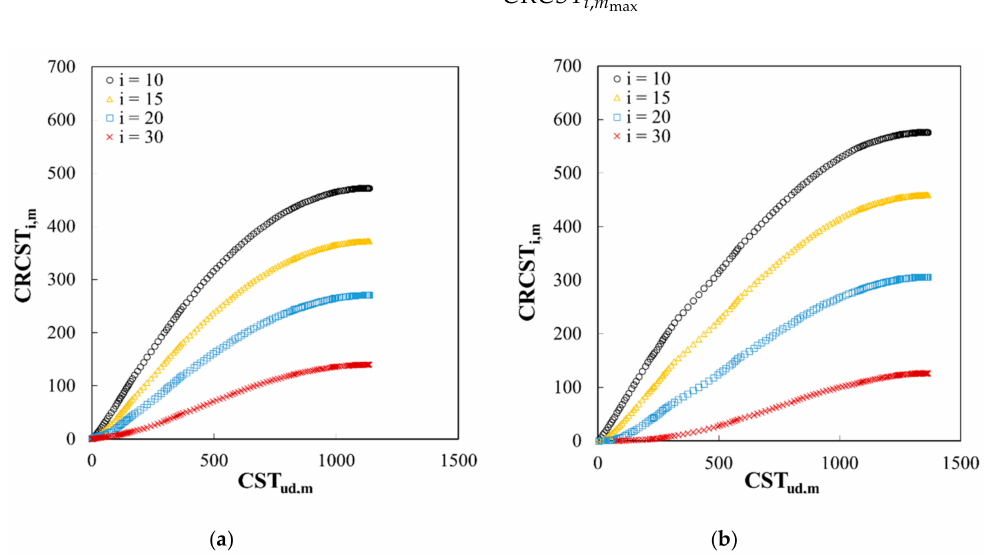
Figure 6. CRCST i,m and CST ud,m curves for the ( a ) site A and ( b ) site B.